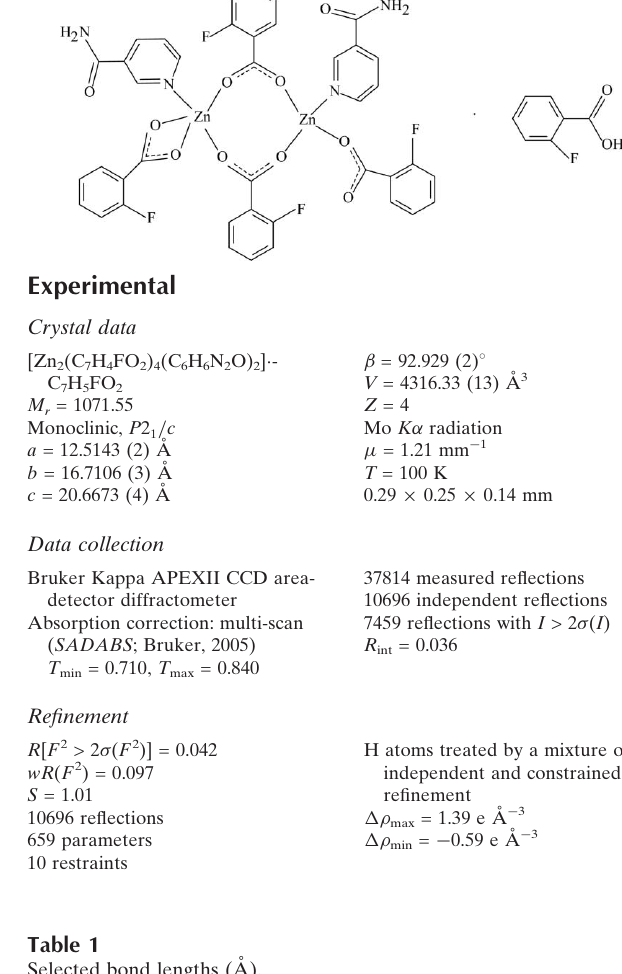
The asymmetric unit of the title compound, [Zn bridged by two carboxyl groups of 2-fluorobenzoate (FB) anions and a 2-fluorobenzoic acid molecule. The two bridging FB anions, one chelating FB anion and one nicotinamide (NA) ligand coordinate to one Zn cation with a distorted square- pyramidal geometry, while the two bridging FB anions, one monodentate FB anion and one NA ligand coordinate to the other Zn cation with a distorted tetrahedral geometry. Within the binuclear molecule, the pyridine rings are oriented at a dihedral angle of 19.41 (14) (cid:3) . In the crystal structure, the uncoordinated 2-fluorobenzoic acid molecules are linked by O—H (cid:2) (cid:2) (cid:2) O hydrogen bonding, forming centrosymmetric supramolecular dimers. Intermolecular N—H (cid:2) (cid:2) (cid:2) O hydrogen respectively, centroid–centroid distances =